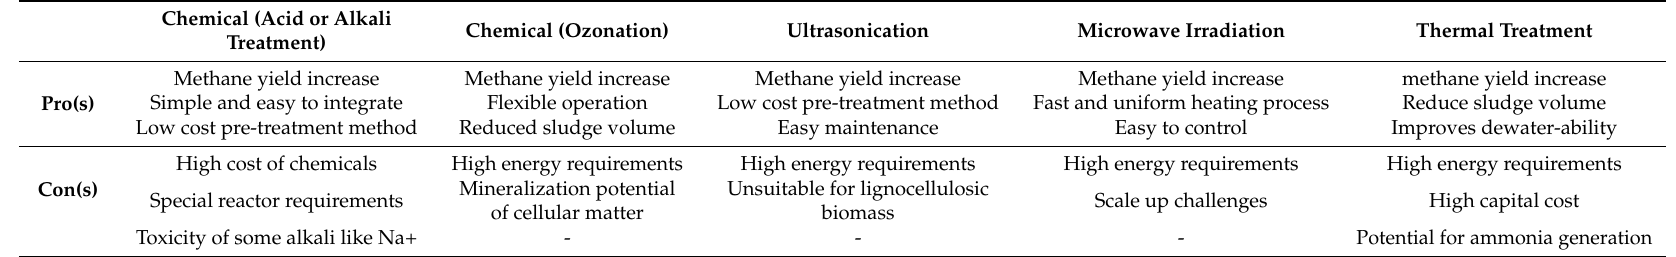
Table 2. Advantages and disadvantages of various sludge pre-treatment